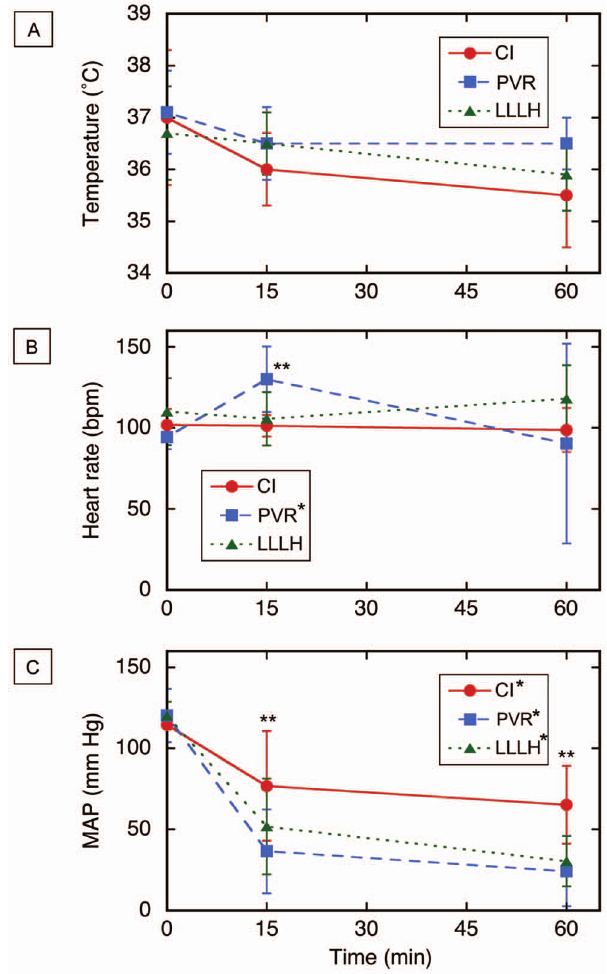
Figure 4. Vital sign data for three porcine models of noncompressible truncal hemorrhage. (A) Temperature. (B) Heart rate. (C) Mean arterial pressure (MAP). Time zero=moment of injury; CLI=central liver injury (N=6); PVR=portal vein resection (N=6); LLLH=hepatic left lower lobe hemitransection (N=10). Values shown are mean 6 sd; *p , 0.05, Kruskal–Wallis one-way analysis of variance on all three time points for a given injury; **p , 0.05, Kruskal–Wallis one- way analysis of variance on all three injuries at the indicated time point. Also refer to Table S2 in file S2.